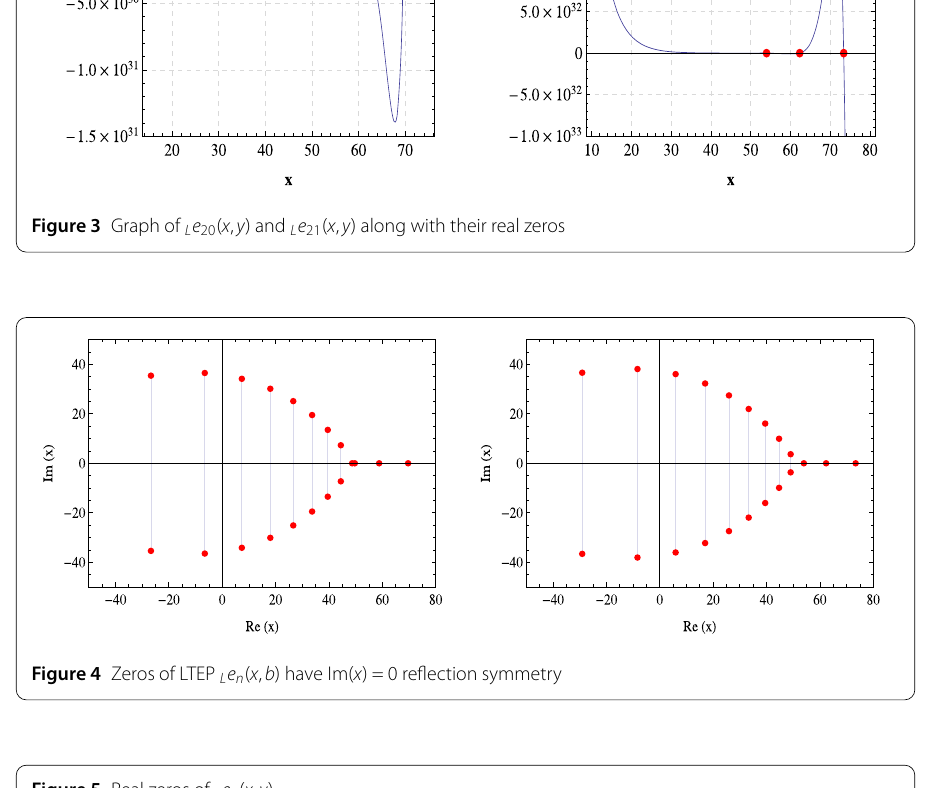
Figure 5 Real zeros of L e n ( x , y